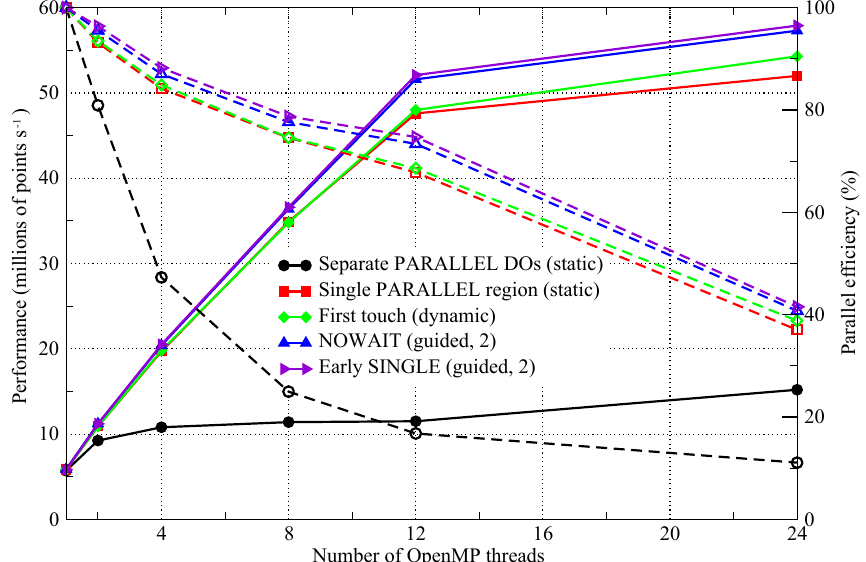
Figure 7. Performance of the OpenMP-parallel version of PSyKAl NEMOLite2D for the 256 2 domain with the Gnu compiler on a single Intel Ivy Bridge socket. The corresponding parallel efficiencies are shown using open symbols and dashed lines. The 24-thread runs employed hyperthreading and the optimal OpenMP schedule is given in